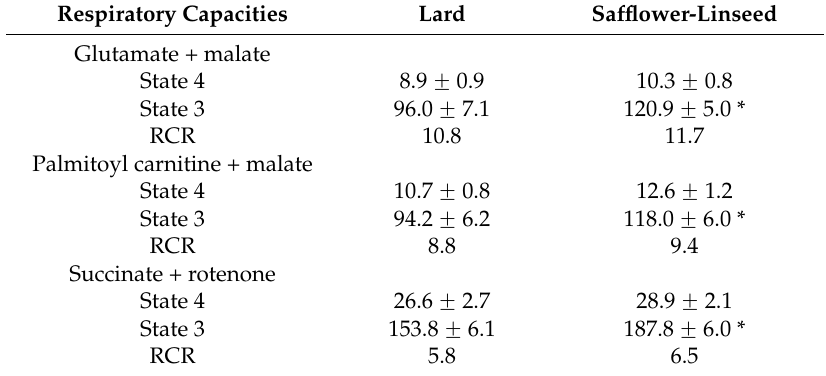
Table 4. Mitochondrial respiratory capacities in rats fed lard or safflower-linseed high fat diet. Respiratory Capacities Lard